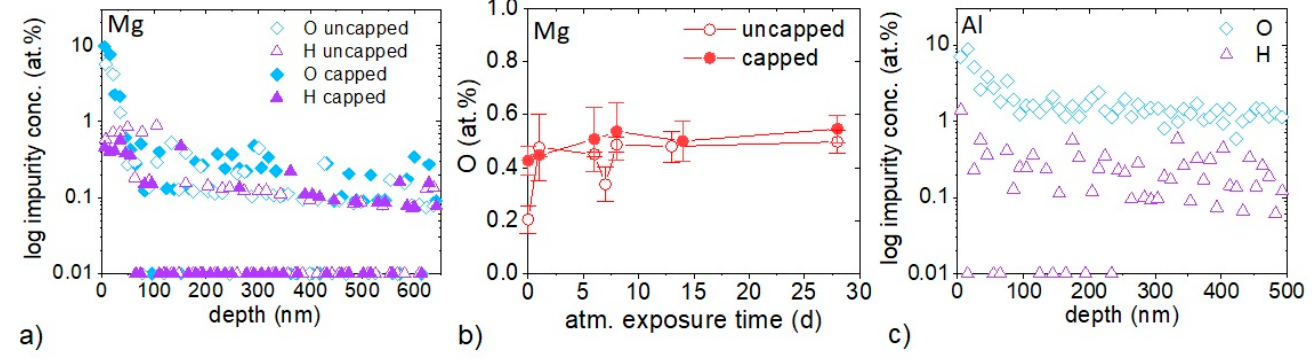
Figure 1. Impurity uptake in Al-capped and uncapped Mg, as well as in uncapped Al films all deposited at 100 °C: ( a ) ERDA composition depth profiles of O and H impurities after 86 days of atmosphere exposure of uncapped and capped Mg. ( b ) EDX measured O concentration as a function of their atmosphere exposure time (expressed in days (d)) after synthesis for capped and uncapped Mg films. ( c ) ERDA composition depth profiles of O and H impurities after 87 days of atmosphere exposure into uncapped Al. Al-capping layers were deposited at ≤ 50 °C.